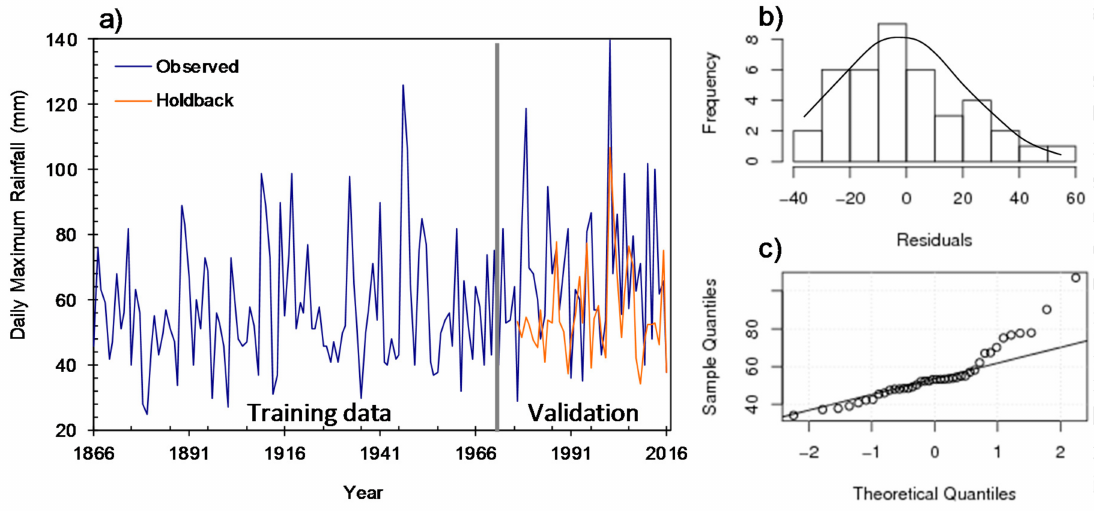
Figure 3. ( a ) Observed time series (blue curve 1866–2016), and simulated time series in the validation period between 1977 and 2016 (red curve); ( b ) Histogram of the Studentized residuals versus predicted values (validation period) with the bell-shaped curve of normal (Gaussian) distribution superimposed; ( c ) Q-Q (quantile-quantile)